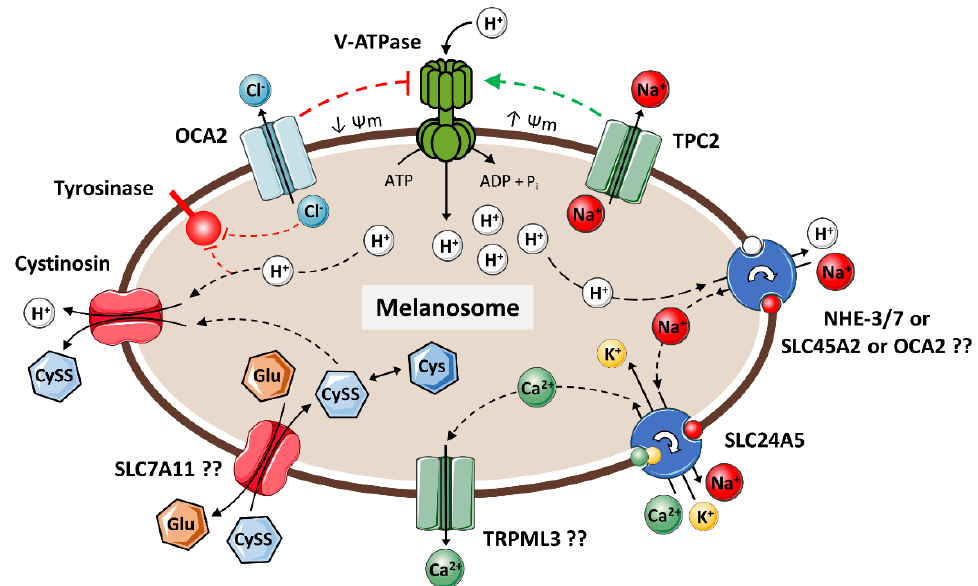
Figure 6. Schematic representation of the cascade of ion channels and transporters with a role in melanogenesis. Melanosome acidification, needed in the early stages of melanosome maturation, is accomplished by V-ATPases. To increase the melanosomal pH, which allows for melanogenesis, the H + protons are returned to the cytoplasm through sodium–proton exchangers, namely NHE-3 and NHE-7. OCA2 is a chloride (Cl - ) channel that reduces proton import into melanosomes, neutralizing the luminal pH and activating the pH-sensitive TYR enzyme. SLC45A2 has also been proposed to act as proton/glucose exporter, respectively. The excess of Na + needs to be cycled out of the melanosomes, which involves SLC24A5. The exchanger activity of SLC24A5 also provides a link between cytosolic and melanosomal Ca 2+ . TPC2 was found to function as an Na + -selective channel, providing the negative regulation of melanogenesis by increasing melanosomal membrane potential and acidity, possibly by providing a cation counterflux to enhance the H + transport by V-ATPases. The counterbalance of Ca 2+ influx can be accomplished by TRPML3, to the neutralization of melanosomal pH. Cystinosin is a cystine/H + symporter that controls the efflux of cystine; its ability to efflux protons along with cystine also renders it as having a role in the control of melanosomal pH. Moreover, the coordinated activities of both cystinosin and SLC7A11 may determine the levels of melanosomal cysteine, therefore influencing the eumelanin/pheomelanin ratio. Cys: cysteine; CySS: cystine; Glu: glutamate; NHE: sodium hydrogen exchanger; OCA2: oculocutaneous albinism 2 protein; SLC(7A11/24A5/45A2): solute carrier family 7/24/45, member 11/5/2; TPC2: two pore segment channel 2; TRPML3: transient receptor potential cation channel, mucolipin subfamily, member 3; V-ATPase: vacuolar